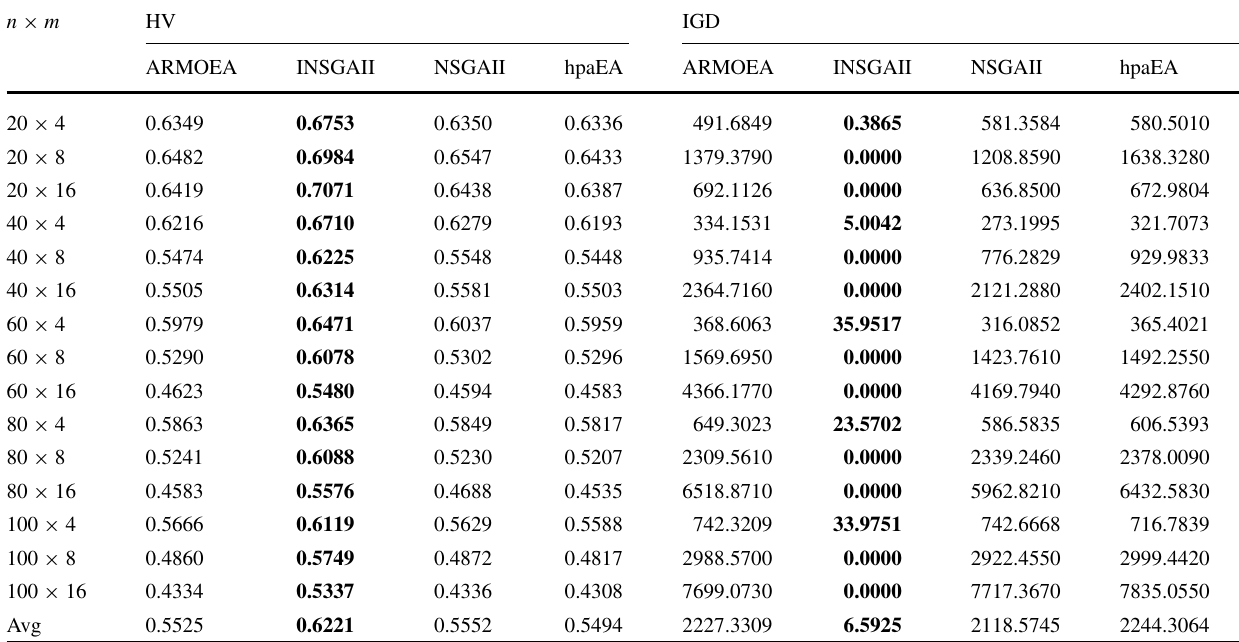
Table 11 Results of the algorithms ( g (cid:2)